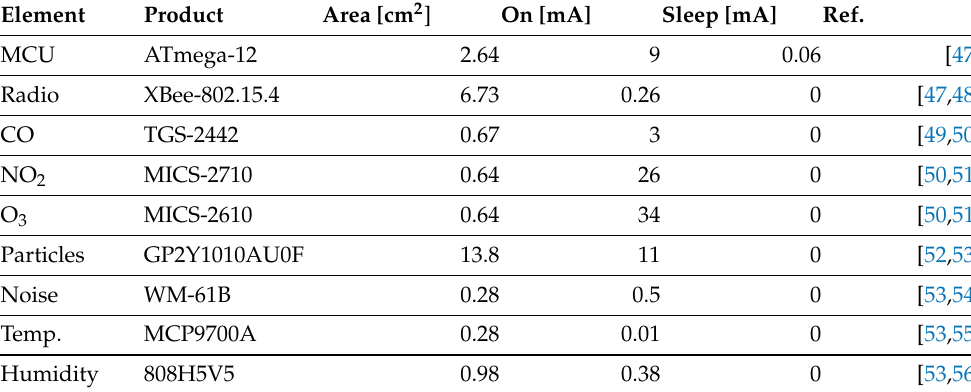
Table 2. Datasheet parameters of the device